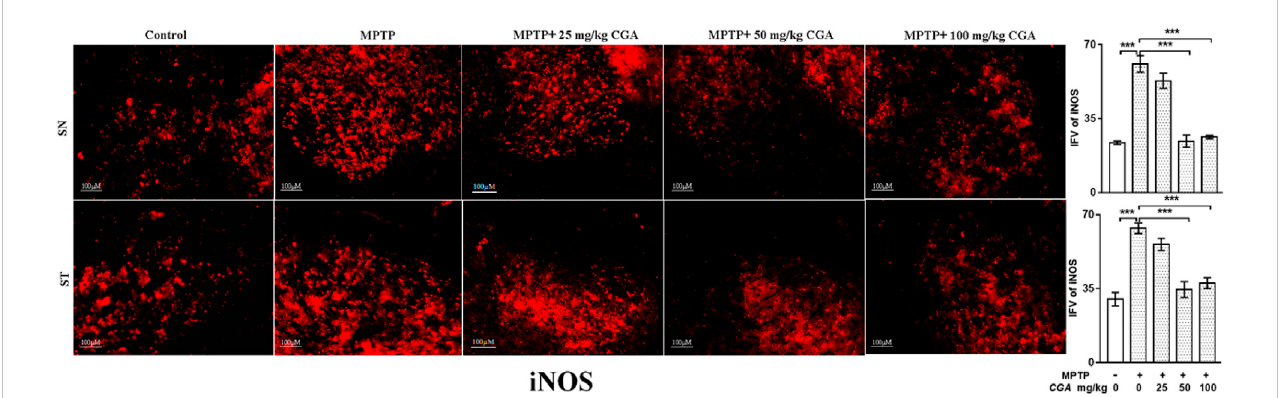
FIGURE 8 IHCofiNOSintheSNandstriatum ofmice.With10×magni fi cationsafter staining.Theincreasedexpression ofiNOSintheSNandstriatumwasfoundin theMPTP-treatedmicecomparedtocontrolmice,whereasCGAsupplementationreducedtheexpressionofiNOSinmicecomparedwithMPTP-intoxicated mice. Values are expressed as mean SEM (n = 3). p < 0.05, ; p < 0.01, and p < 0.001. CGA, chlorogenic acid; MPTP, 1-methyl-4-phenyl-1,2,3,6- tetrahydropyridine; SN, substantia nigra; ST, striatum; iNOS, inducible nitric oxide synthase; SEM, standard error of mean; IFV, integrated fl uorescent